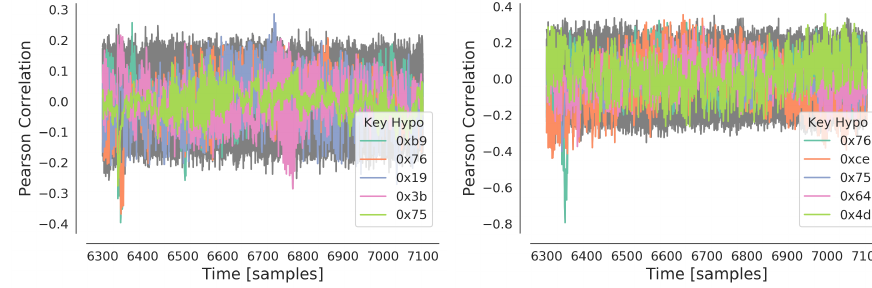
Figure 21: Pearson Correlation coefficients in Step 3 with 256 traces (left) and 128 traces (right) (byte